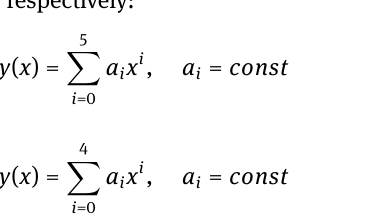
sumed parallel to the rotational axis x , the trailing edge is Tip and hub endwalls are described by the curves con- sisting of an arc and a straight segment associated with walls are: r , r - maximum and minimum radiuses of max min the rotor channel; x rotor width; l , l - inlet and exit max ex in - angles of the tip and hub heights; α hub , α hub , α tip , α tip ex ex in in